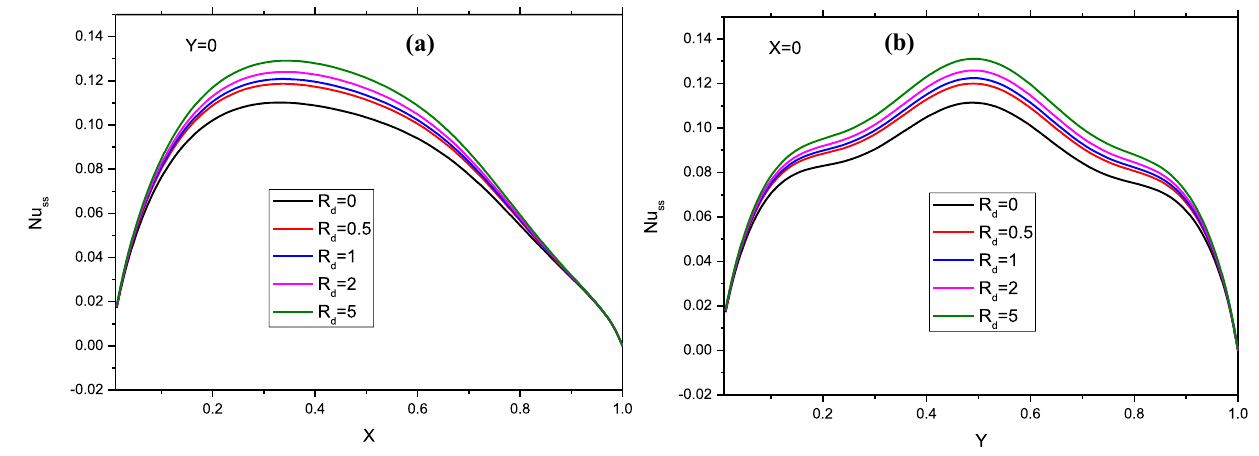
Ha = 10 , Q = 1 , Da = 10 – 3 , Ri = 1 , Gr = 1 , H * = 10 , ε = 0 . 5 , γ = 0 . 5 , Φ = π/ 3 , c